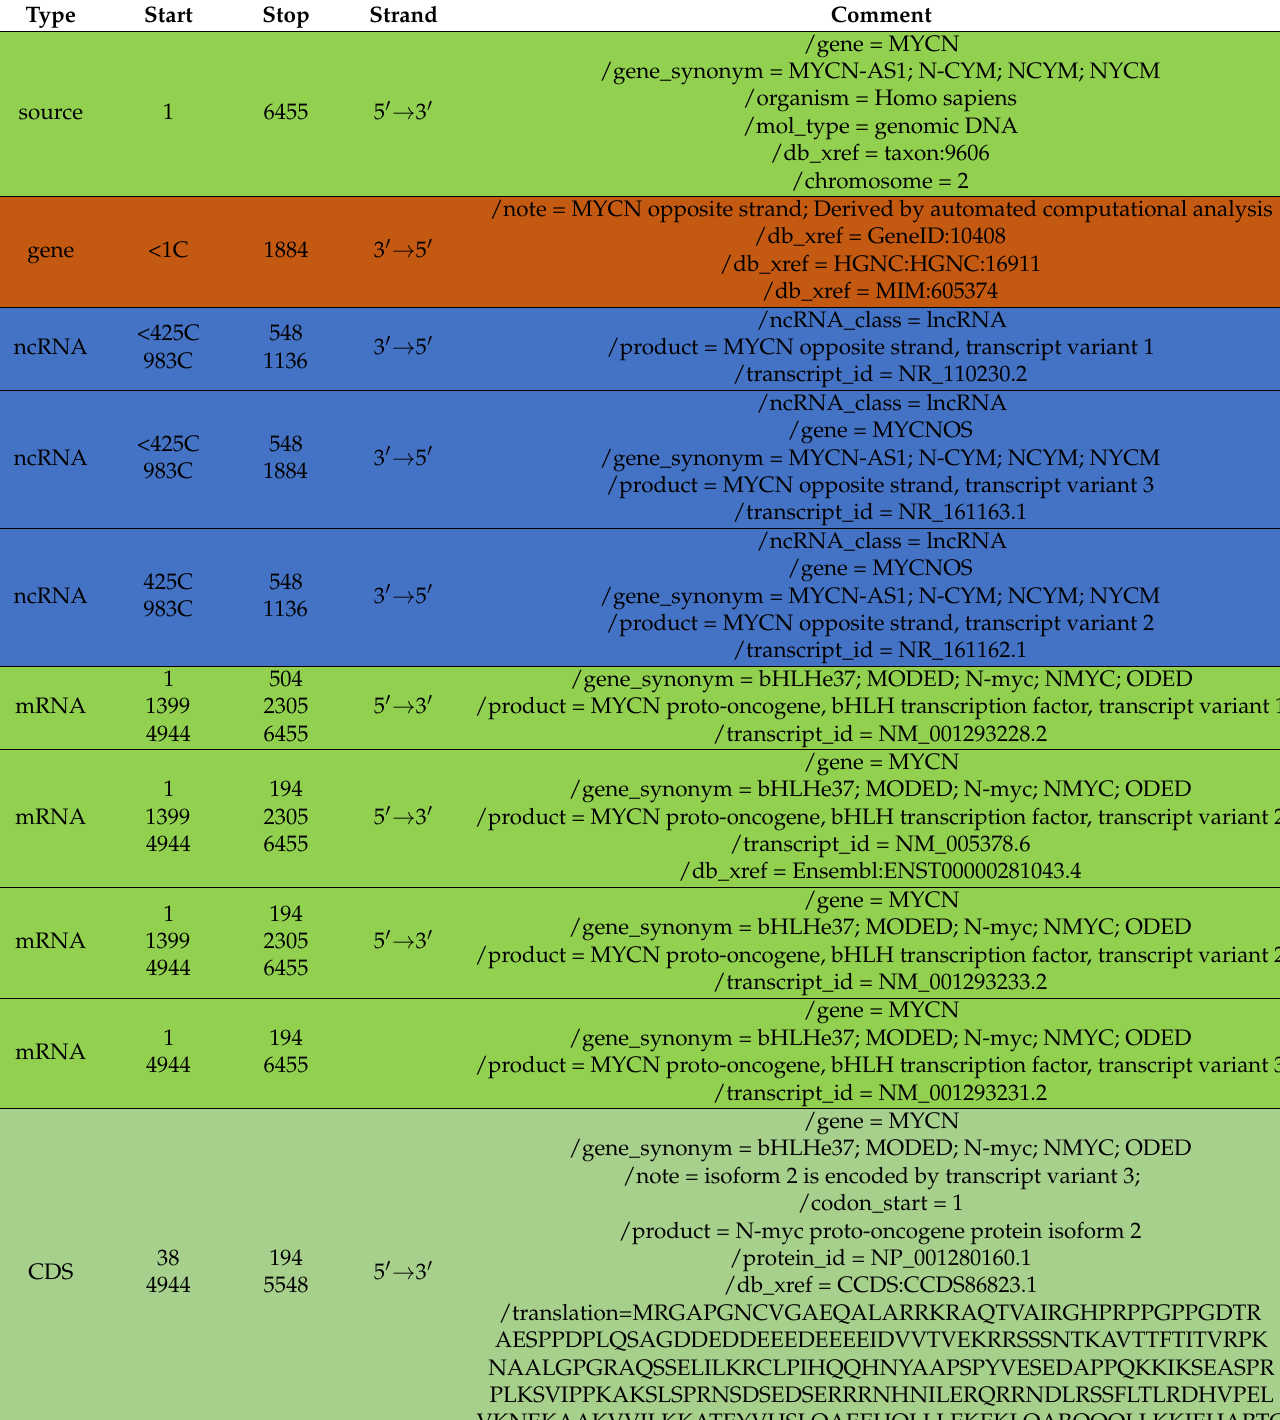
Table 1. The analysis of the MYCN gene (table has been reproduced from the NCBI provided data https://www.ncbi.nlm. nih.gov/gene/4613, accessed on 20 June